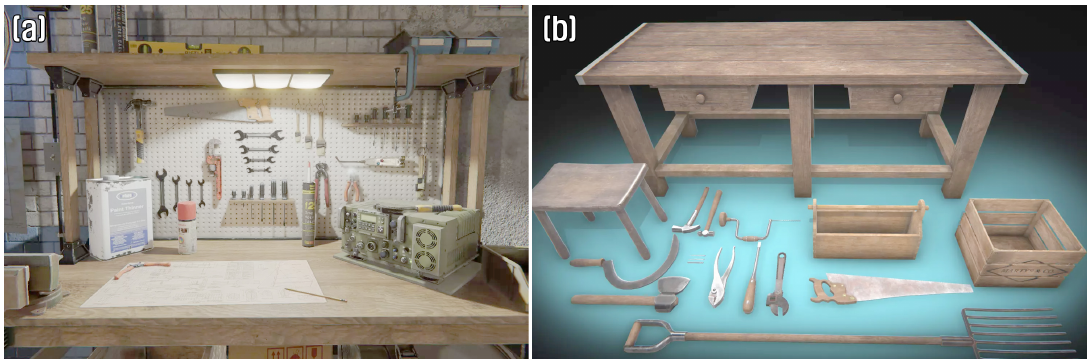
Figure 8. Various application examples of applying the interface proposed in this study: ( a ) DIY workshop; ( b )